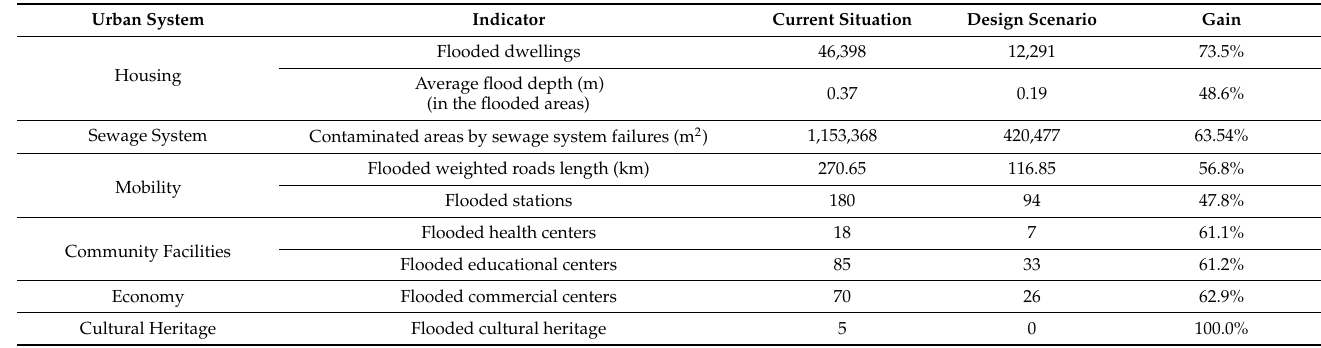
Table 4. Comparison between Current Situation and Design